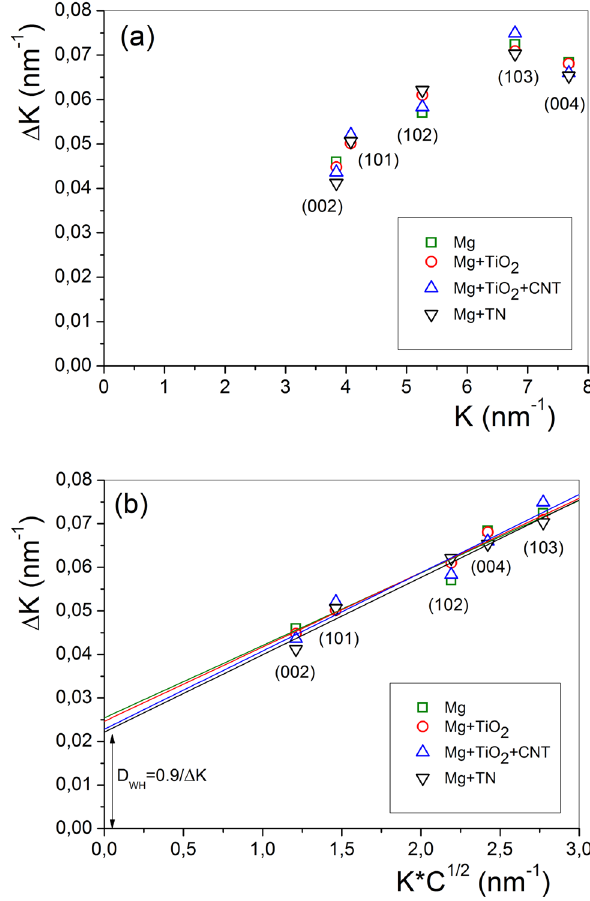
Figure 4: Mg lattice parameters ( a and c ) of the Mg - based compo - sites. Dashed lines indicate the literature value. Figure 5: ( a ) Classical and ( b ) modi fi ed Williamson – Hall